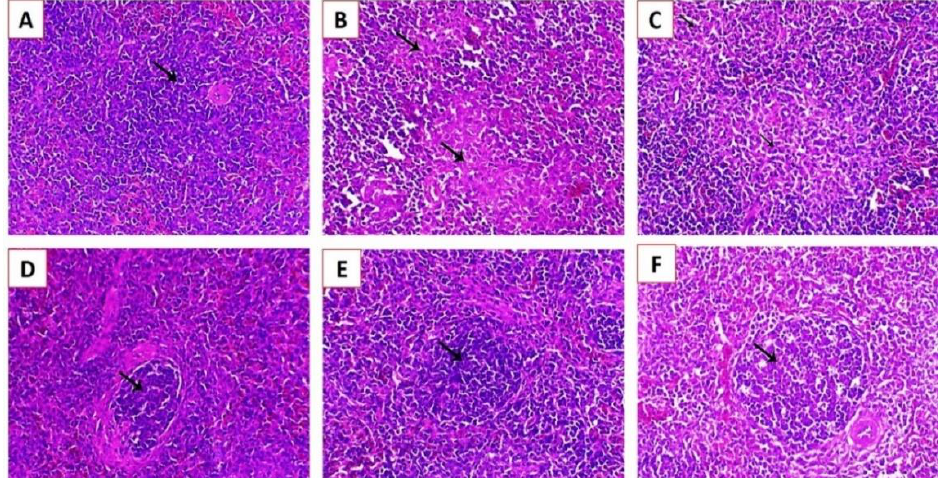
Figure 9. Histopathological lesions in the splenic tissues of experimentally infected Cobb chickens 5 dpi: ( A ) Scheme 4 showing a normal lymphoid follicle with normal lymphocytes around the central arteriole (arrow); ( B ) spleen of an experimentally infected bird in G1 showing marked lymphoid depletion associated with marked histocytic cell proliferation (arrows); ( C ) spleen of an experimentally infected bird in G2 showing marked histocytic cell proliferation (arrows); ( D ) spleen of an experimentally infected bird in G2 showing a normal lymphoid nodule (arrow); ( E ) spleen of an experimentally infected bird in G3 showing an increase in lymphoid cell proliferation within the white pulp (arrow); and ( F ) spleen of an experimentally infected bird in G3 showing increased lymphoid cell proliferation (arrow) (H&E, X200).